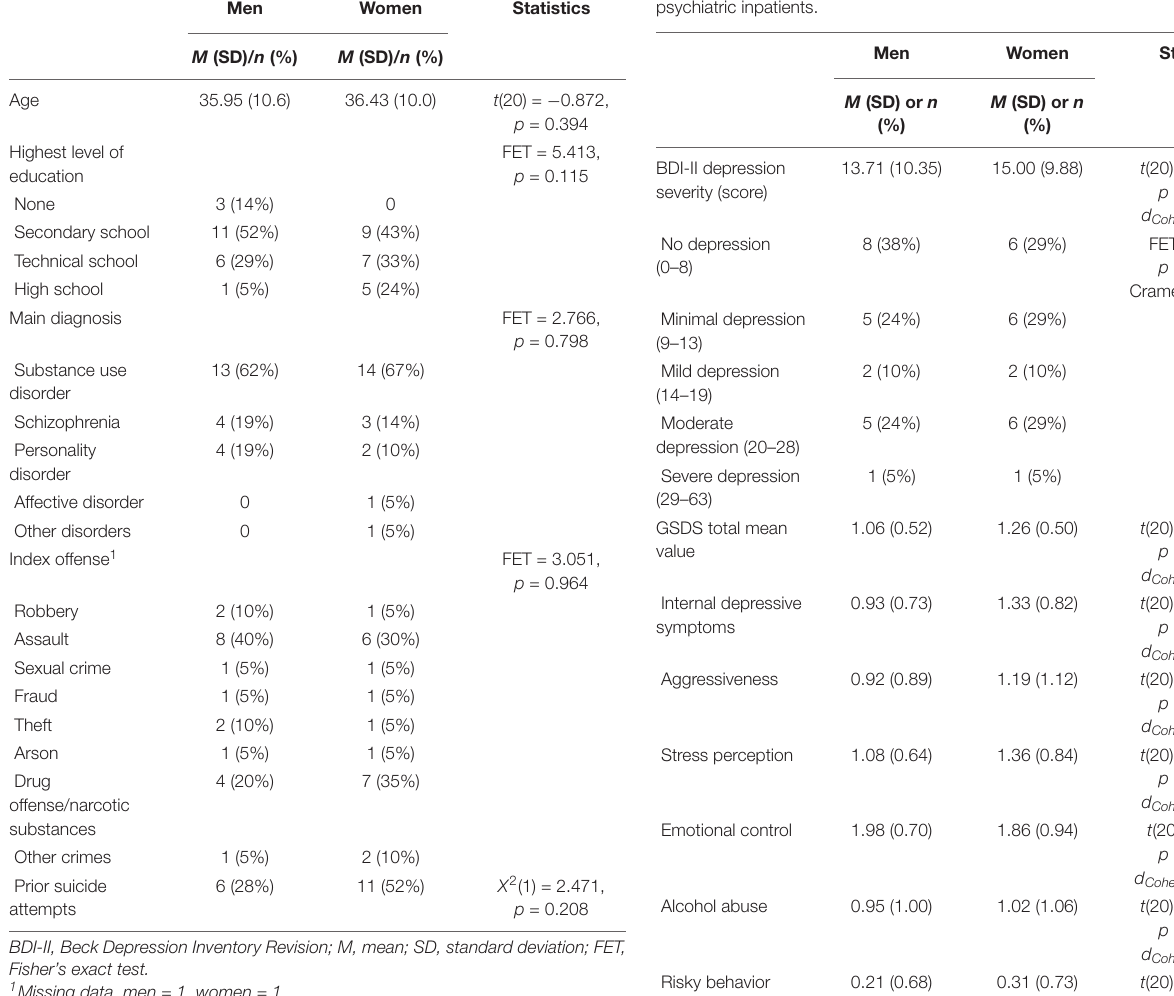
TABLE 2 | Descriptive statistics of the Beck Depression Inventory Revision (BDI-II) and Gender-Sensitive Depression Screening (GSDS) in an age- and